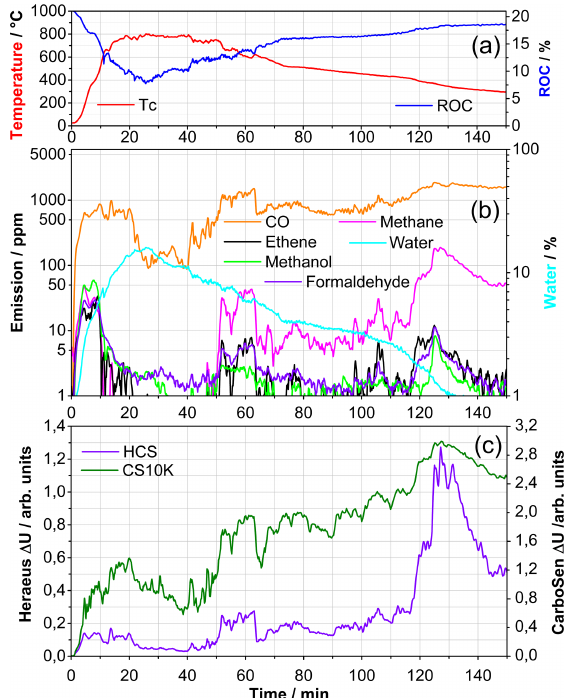
Figure 4. Course of (a) the combustion temperature ( T c ) and the residual oxygen concentration (ROC), (b) the FTIR flue gas analysis and (c) the CO / HC sensor signals of CS10K and HCS in a typical wood-log combustion batch firing experiment.